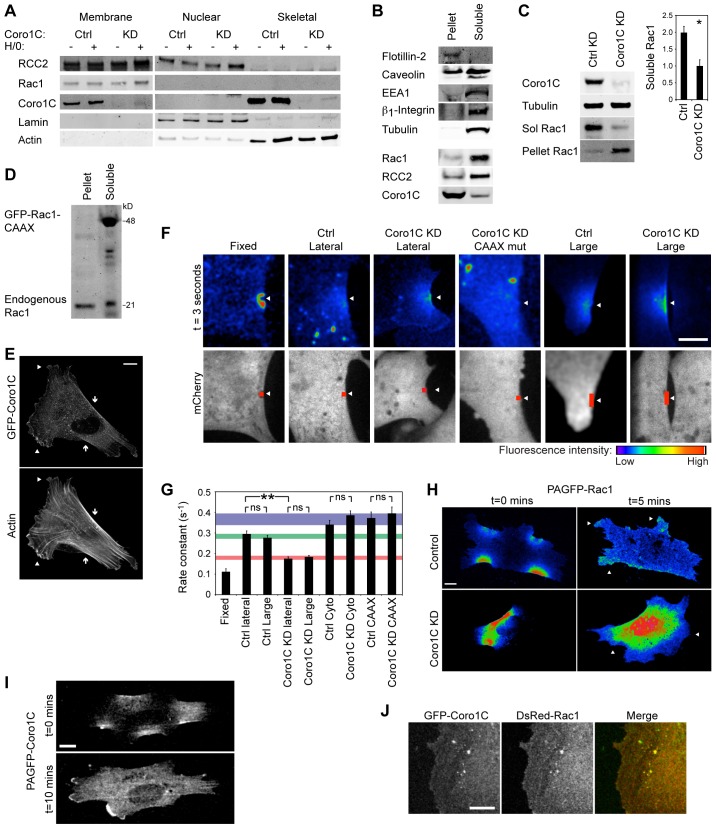
Coro1C mediates relocalization of Rac1 from lateral to protrusive membrane. (A) Protein distribution between total membrane, nuclear and cytoskeletal fractions using a Qproteome kit. Comparison of control (Ctrl) and Coro1C-knockdown (KD) fibroblasts, with and without syndecan-4 engagement (H/0), n = 4. (B) Coro1C localized to detergent-resistant (1% Nonidet P-40) membrane that includes flotillin-2 (Pellet). Rac1 and RCC2 localized to detergent-soluble lysate that includes EEA1, β1 integrin and tubulin, n = 8. (C) Rac1 was displaced from the detergent-soluble to insoluble fraction upon knockdown of Coro1C. *P<0.05 (Student's t-test), n = 8. (D) Mutation of the CAAX box caused GFP–Rac1 to remain in the detergent-soluble fraction of Coro1C-knockdown MEFs, n = 4. (E) GFP–Coro1C localized to both lateral (arrows) and ruffling (arrowheads) membrane. Representative of 100 cells. (F,G) Coro1C slows release of photoactivated (PA)GFP-tagged Rac1 from the membrane. (F) 1.5-µm or 4.5-µm sections (red boxes) of lateral membrane, identified by co-transfection with mCherry, were photoactivated at 405 nm, and dispersion of PAGFP-tagged Rac1 from the central 1.5 µm (arrows) was followed at 488 and 525 nm. Panels show sample images at 3 s post-activation, taken from supplementary material Movie 3. (G) Rate constants of fluorescent decay, comparing Coro1C-knockdown with control MEFs, using full-length or CAAX-mutant PAGFP–Rac1. **P<0.005 (by F-test); ns, not significant, n = 18. (H,I) In control, but not Coro1C knockdown MEFs, PAGFP-tagged Rac1 (H) and Coro1C (I) activated in lateral membrane was recruited to protruding membrane (arrowheads). Frames from supplementary material Movies 4 and 5, n = 15. (J) GFP–Coro1C and DsRed–Rac1 colocalize in vesicles. Results are mean±s.e.m. Scale bars: 10 µm.